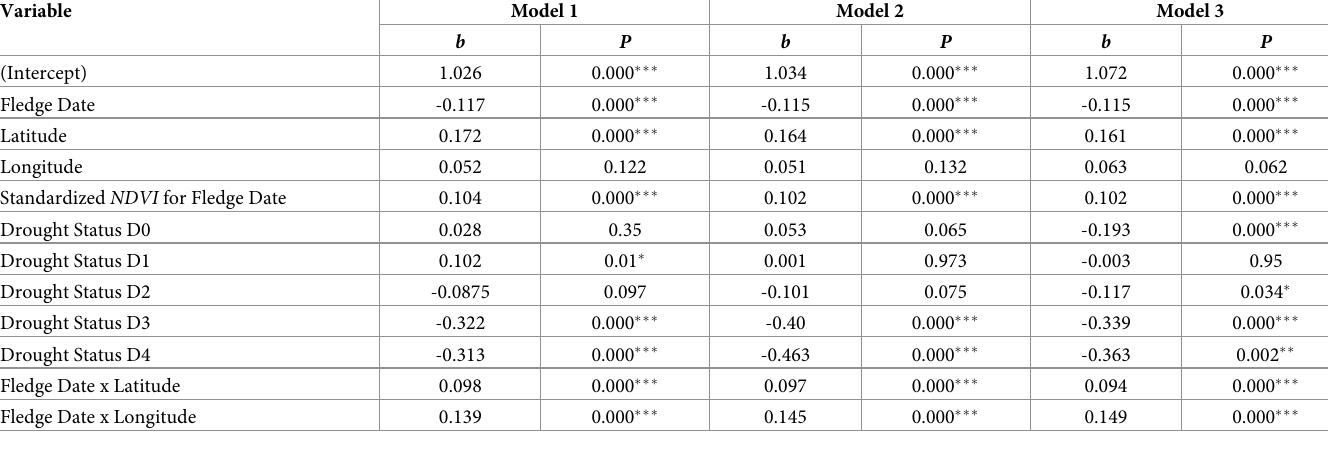
Table 4. Parameter β estimates ( b ) and probabilities ( P ) for three generalized linear models used to evaluate drought effects on Eastern Bluebird fledging success rate. Explanatory variables are Julian fledge date, latitude, longitude, standardized NDVI for the Julian fledge date, drought status during the Julian fledge date, and inter- actions between Julian fledge date and latitude and longitude, respectively. Models 2 and 3 evaluate drought status 30 and 60 days prior to the Julian fledge